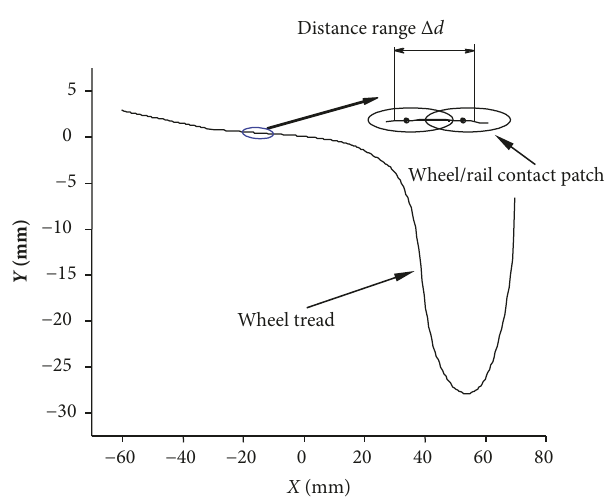
Figure 2: Calculation model of cumulative wear power dissipation for wheel